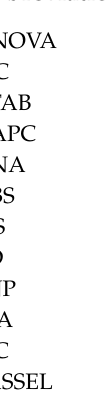
Figure S1: Graph ( A ) Bayesian information criterion versus the number of clusters and ( B ) cross-validation error versus K value, Figure S2: Mantel correlation test performed between the di ff erent dissimilarity matrices alongside the combined matrix. Sim = similarity coe ffi cient, beacon = Mantel threshold indicating the correlation, Table S1: Traits measured, their description and unit, Table S1: Mean squares from the combined ANOVA for traits recorded under infestation condition for 2 years evaluated in 2 locations, Table S3: Mean and standard errors of variables under Striga infestation and Striga non-infestation across the entire four environments, Table S4: Grouping of the 150 inbred lines using 16,735